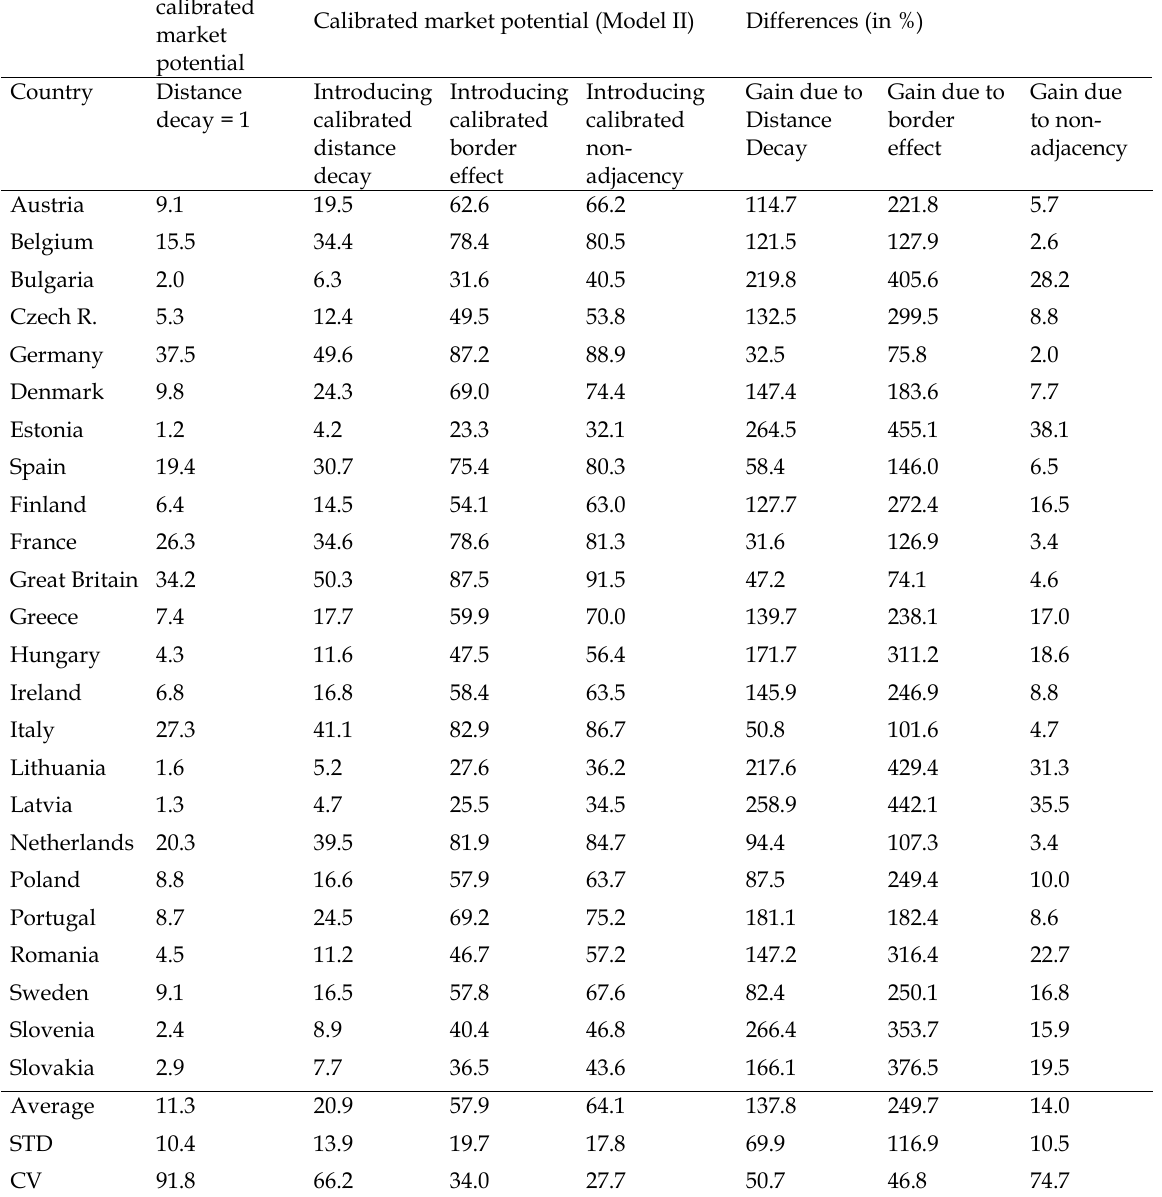
Table 4. Self-potential values: effects of the introduction of the different parameters of